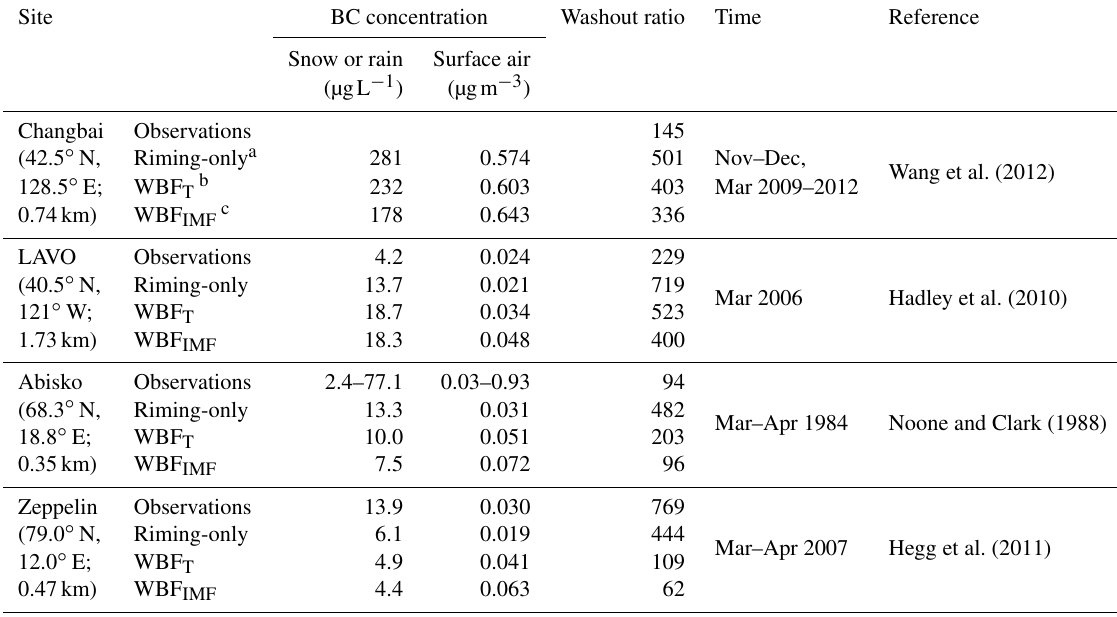
Table 2. Observed and GEOS-Chem-simulated BC concentration in snow and rain (µgL − 1 ), BC concentration in surface air (µgm − 3 ) and the corresponding washout